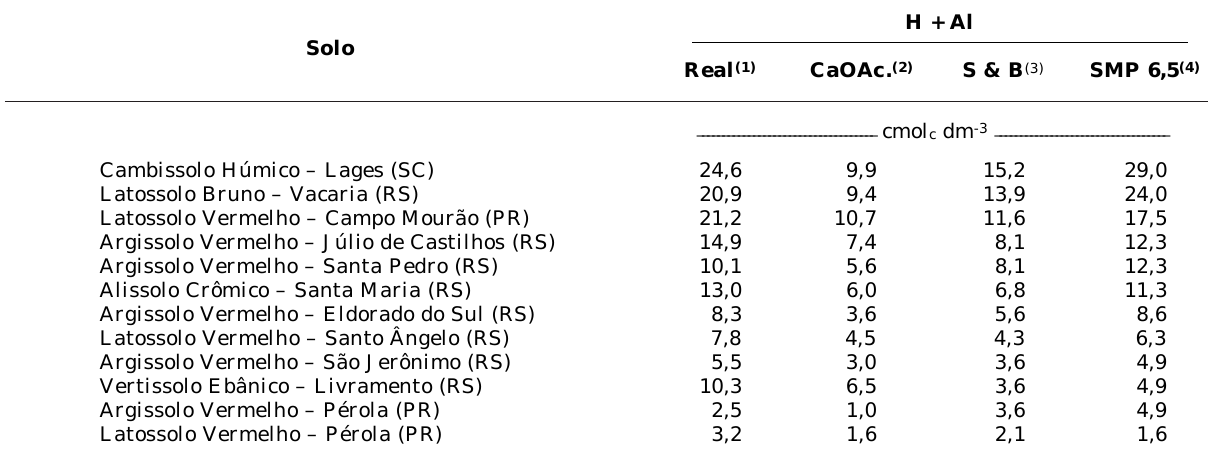
estimada pela equação de Escosteguy & Bissani e estimada a partir da necessidade de calcário pelo índice SMP para pH